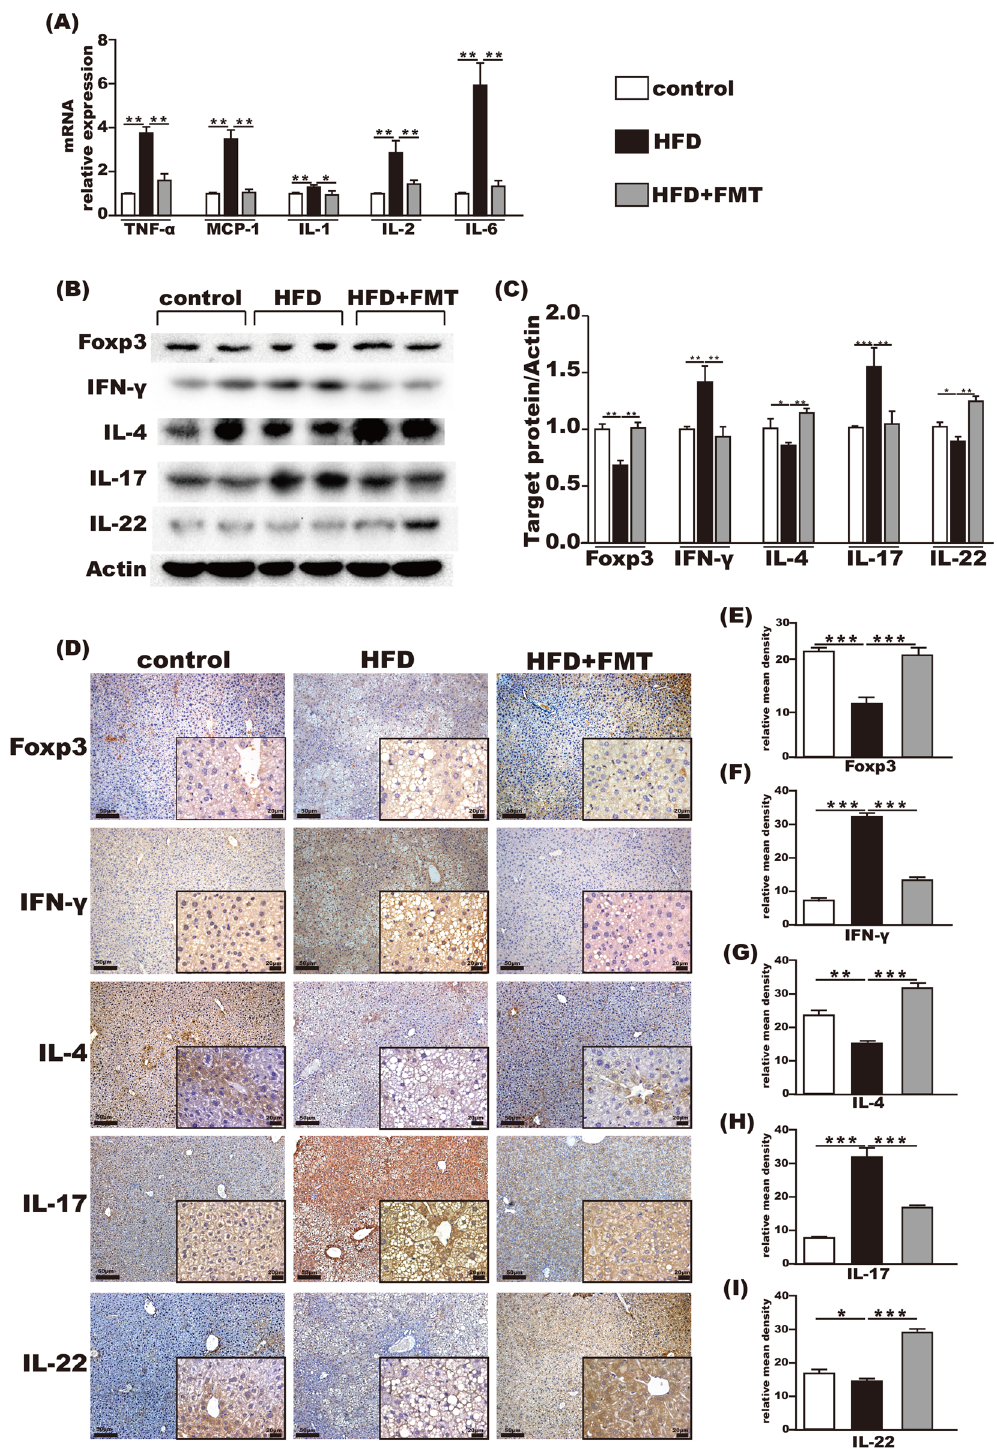
Figure 5. Immunoregulation of FMT in the liver. ( A ) Pro-inflammation-associated gene expression in the liver. ( B,C ) Foxp3, IFN- γ , IL-4, IL-17 and IL-22 protein expression levels in the liver. ( D–I ) Immunohistochemistry for Foxp3, IFN- γ , IL-4, IL-17 and IL-22 in the liver showed that Foxp3, IL-4, and IL-22 were increased and IFN- γ and IL-17 were decreased after FMT intervention. The data represent the mean ± S.E.M. * P < 0.05, ** P < 0.01 and *** P <